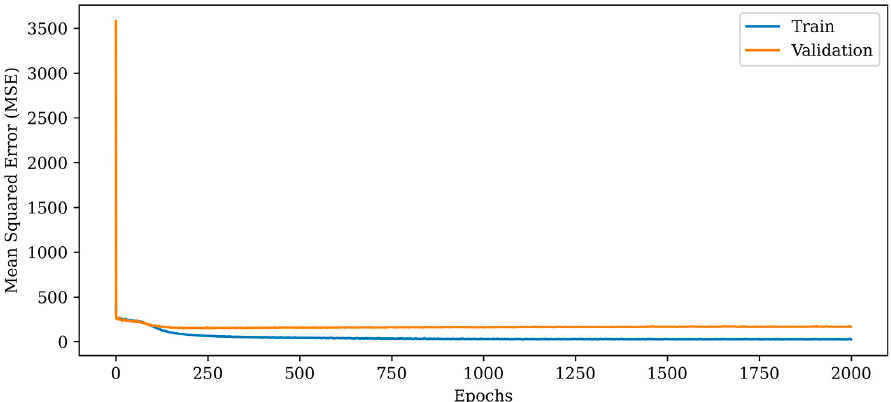
Figure 8. Mean squared error (MSE) curves for training and validation phases of the proposed RV- CNN model. RV-CNN